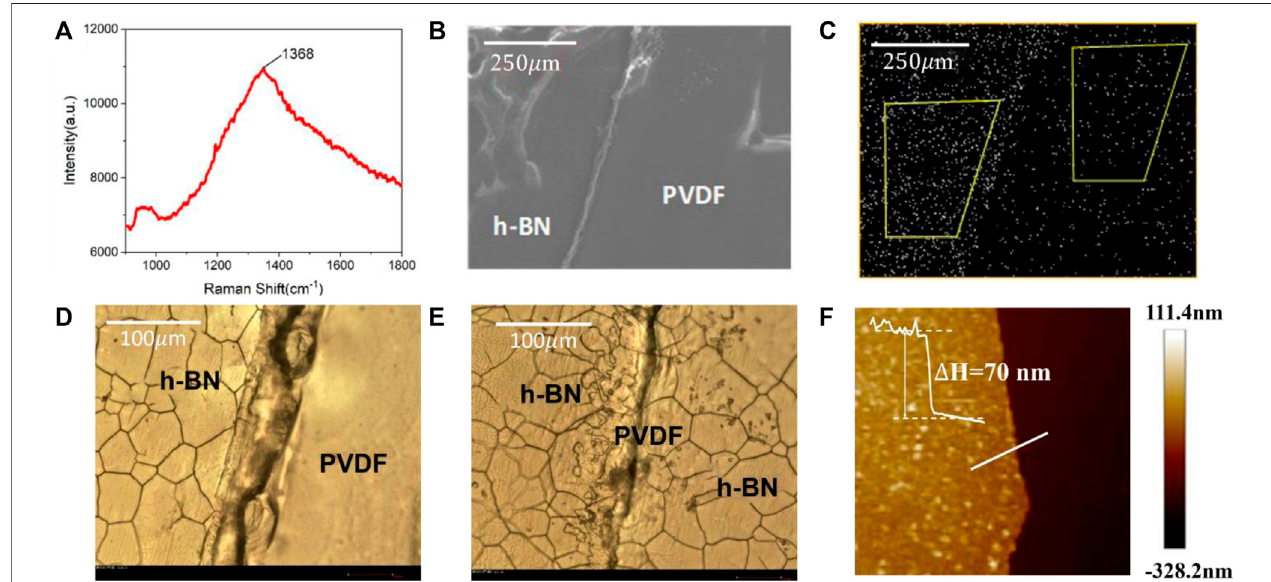
FIGURE 2 | Raman spectrum of the h-BN fi lm on Si/SiO 2 /substrate (A) . SEM image of h-BN/PVDF/h-BN sandwiched-structure (B) . Energy-dispersive spectrometer (EDS) of nitrogen distribution (C) . Optical micrograph of single-layer h-BN (D) . Optical micrograph of h-BN/PVDF/h-BN structure (E) . AFM image of the h-BN/Si fi lm (F)